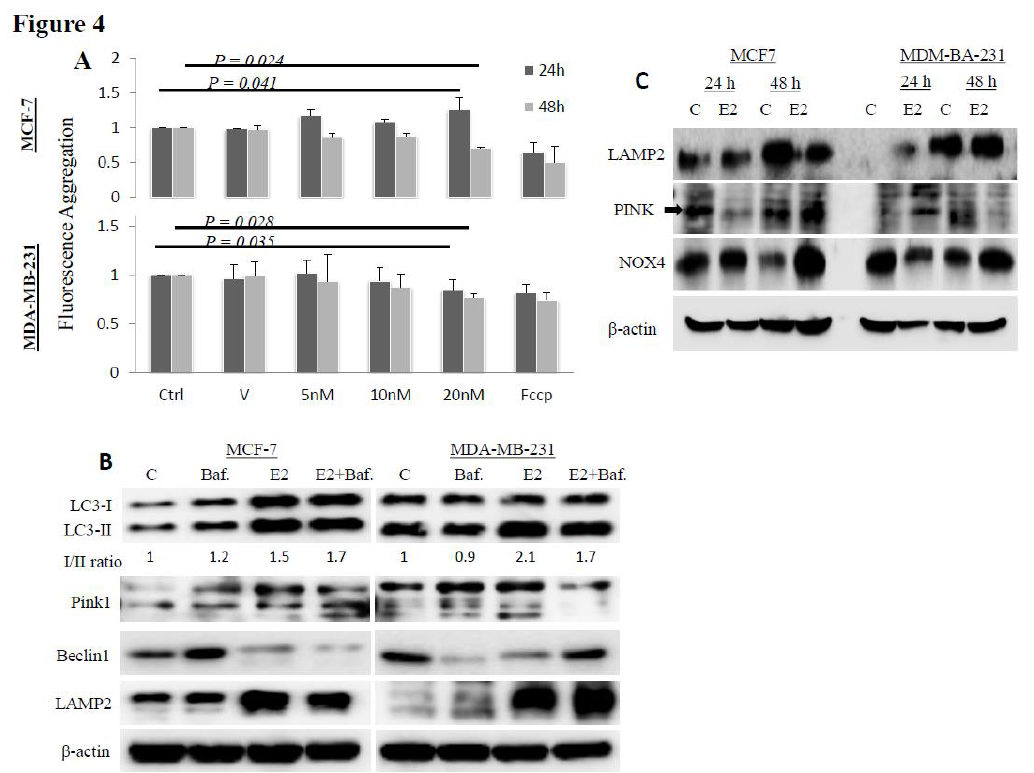
Figure 4. Mitochondrial membrane potential (Δψm) in E2-treated cells. ( A ) Mean + SD of MMP in MCF-7 and MDA-MB-231 cells treated with 20 nM E2 for 24 and 48 h. FCCP-treated cells served as a positive control and untreated cells served as a negative control. Data shown is based on three separate experiments/cell type. ( B ) Expression of the autophagy proteins LC3-I/II and Beclin1, the mitochondrial integrity regulator Pink1, and the lysosome-associated membrane protein 2 (LAMP2) in MCF-7 and MDA-MB-231 cells treated with 20 nM bafilomycin, 20 nM E2 or both for 24 hr. ( C ) Expression of LAMP2, Pink1 and NADPH oxidase 4 (NOX4) in mitochondrial protein lysates isolated from MCF-7 and MDA-MB-231 cells at 24 and 48 h post treatment with E2. Data shown in B and C is representative of three separate experiments each.